Question: Give a one-sentence summary of this figure.
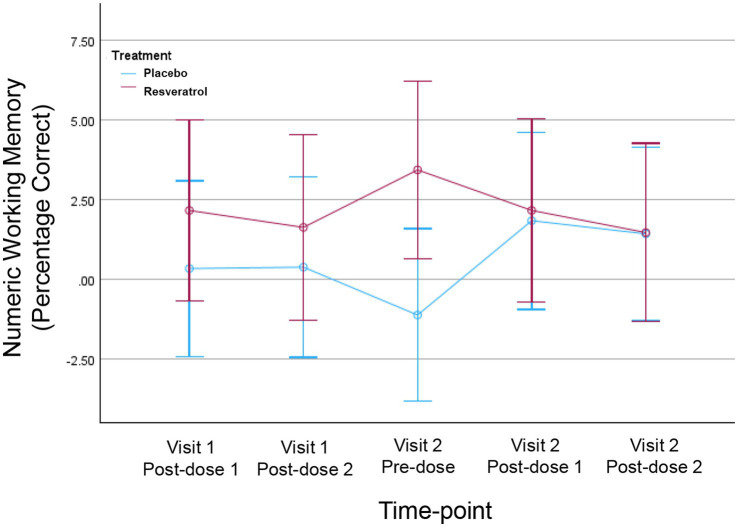
Answer: Numeric working memory ‘percentage correct’ change-from-baseline results.